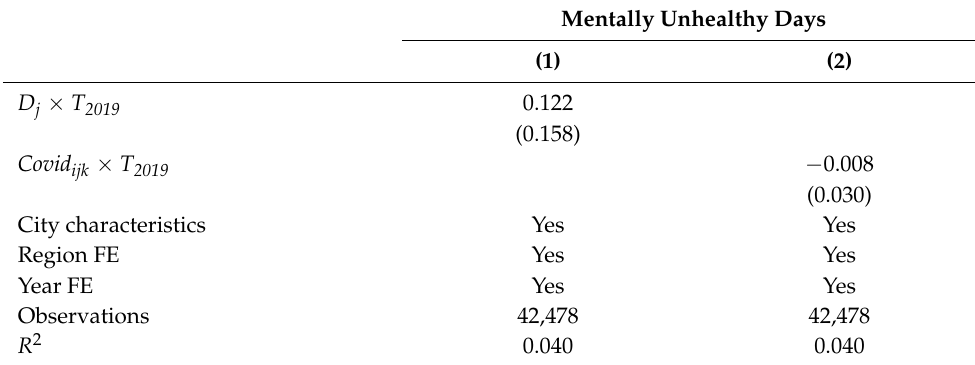
Table 7. Parallel trend